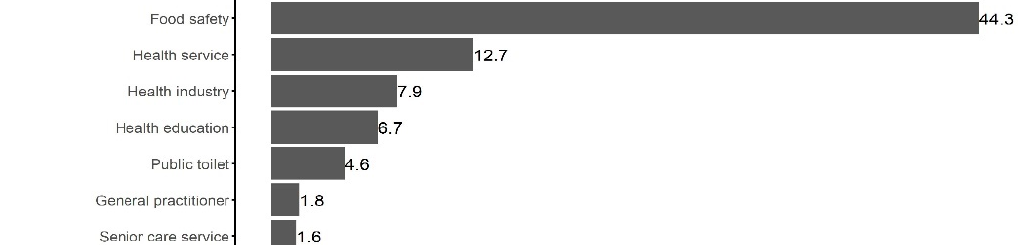
Figure 1. Standardized search queries of the keywords at the city level. Only the keywords with standardized search queries larger than 0.1 per million are shown here.